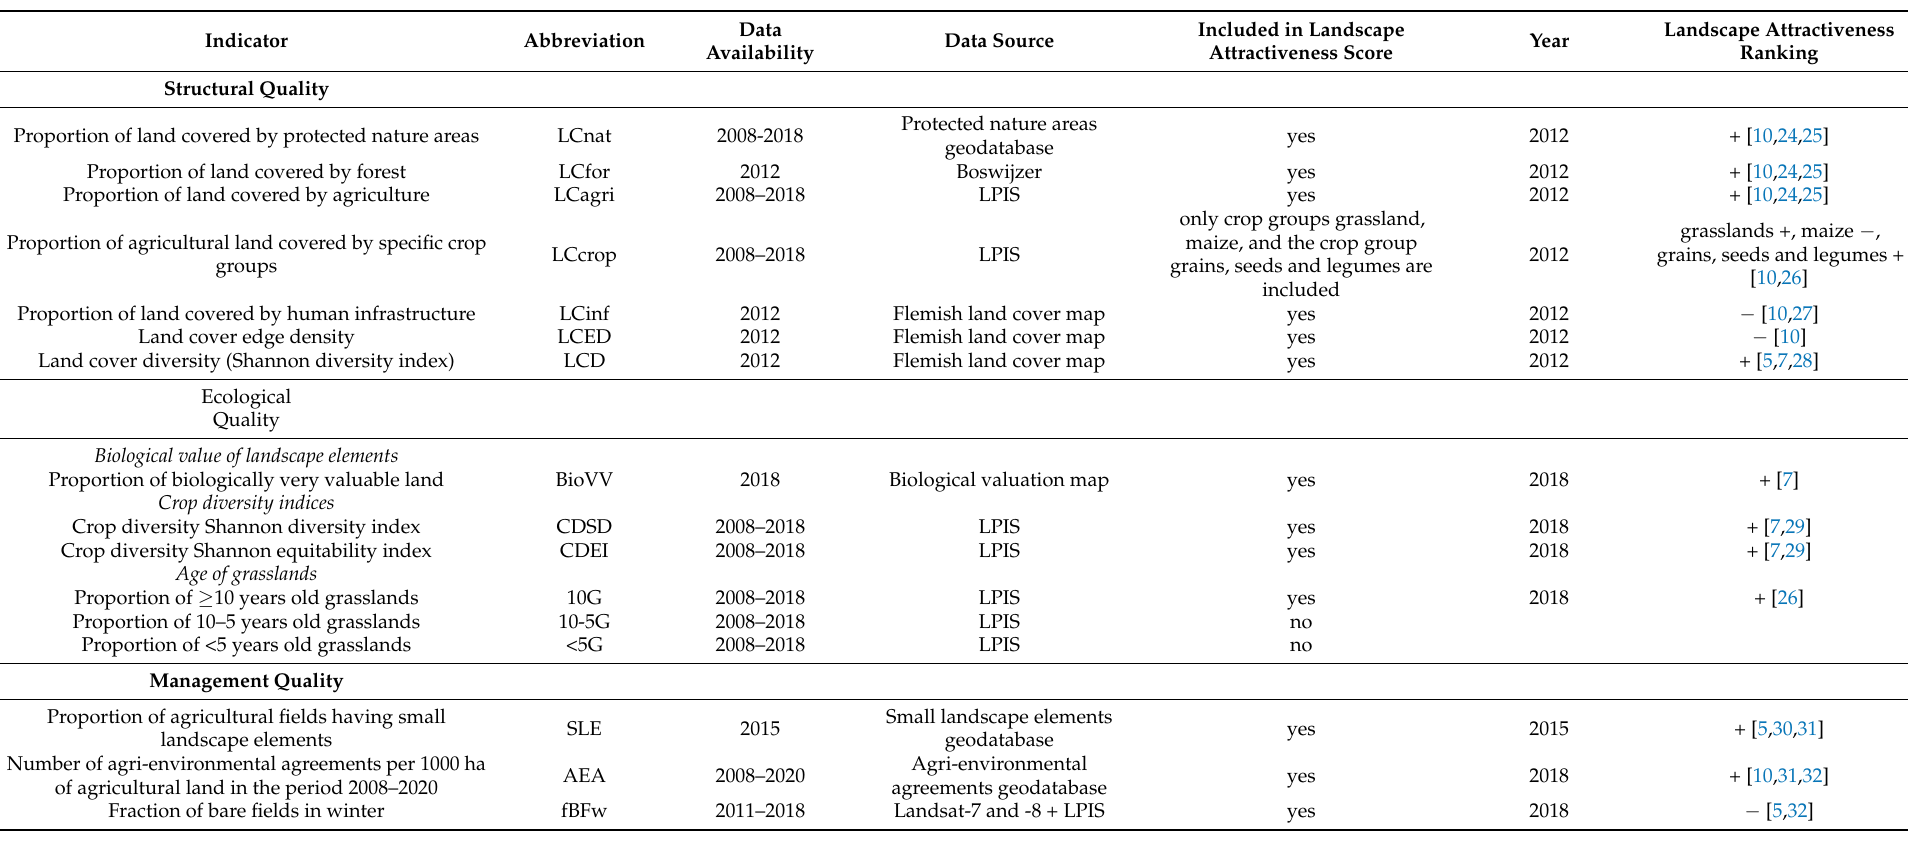
Table 1. Description of indicators used to characterize the structural, ecological and management landscape quality aspects. Data availability indicates the years where the landscape indicator was available. The data source indicates the geodatabases and remote sensing data used for the calculation of these indicators (see Supplementary Materials). “Included in landscape attractiveness score“ indicates if the indicator is used for the calculation of the structural quality, ecological quality and management quality scores and the overall landscape attractiveness score. Year: year of the indicator used for the landscape attractiveness score calculation. Landscape attractiveness ranking: + higher values of the indicator have a positive effect on landscape attractiveness and are higher ranked, − higher values of the indicator have a negative effect on landscape attractiveness and are lower ranked, and